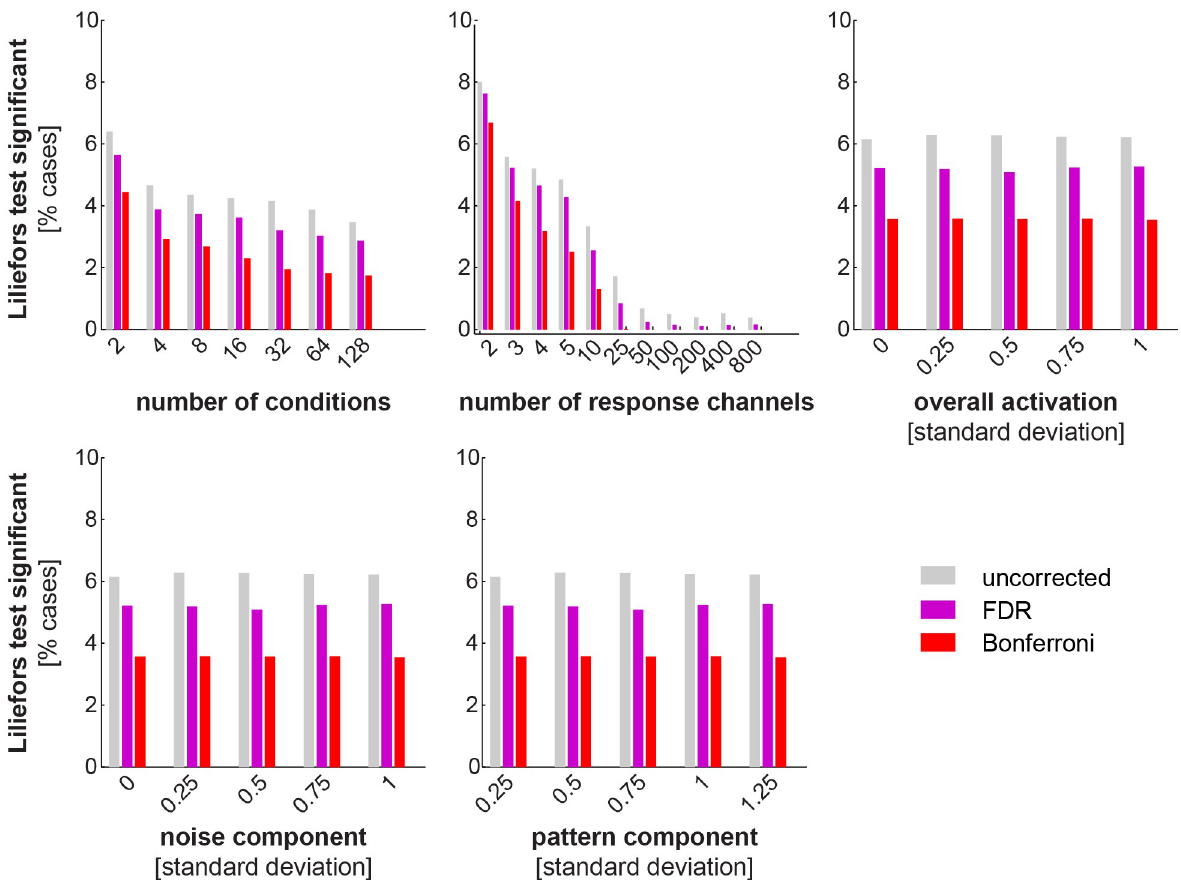
Fig 7. Marginal histograms of deviations from Gaussianity of the simulated EDI null distribution. In order to richly characterise the properties of the EDI distribution under H 0 , we simulate data for a large number of subjects for a range of values of any parameter. At every point of the cross- product parameter space, sdRDMs (based on Pearson correlation distance) were obtained from simulated patterns for 10,000 subjects (patterns were simulated independently for each subject). Lilliefors tests (testing whether the distribution of EDIs is significantly non-Gaussian) were applied to the EDI distributions. These bars correspond to results from the Lilliefors Gaussianity test. A significance threshold of 5% was applied to the tests. Each column also corresponds to one dimension of the parameter space. The first two (number of exemplars and number of response channels) mainly depend on the experiment and analysis and the other three characterise the multivariate response space. For example, the red bar on the leftmost bar-graph would correspond to the proportion of all Lilliefors tests that were significant (p < 0.05, Bonferroni correction) when the number of conditions were fixed at 2, 4, 8, etc. and the other parameters had any possible value. Two other tests were performed in a similar way to test EDIs for the simulated data under H 0 . One was a one-sided Wilcoxon signed rank test and the other a one-sided t test. The signed rank test was applied to assess whether the EDIs were zero centered and the t test was applied to obtain an estimate of the false-positive rates. Interestingly, for both tests less than 1% violations occurred (p < 0.05) and none of those survived correction for multiple comparisons (FDR and Bonferroni, p <